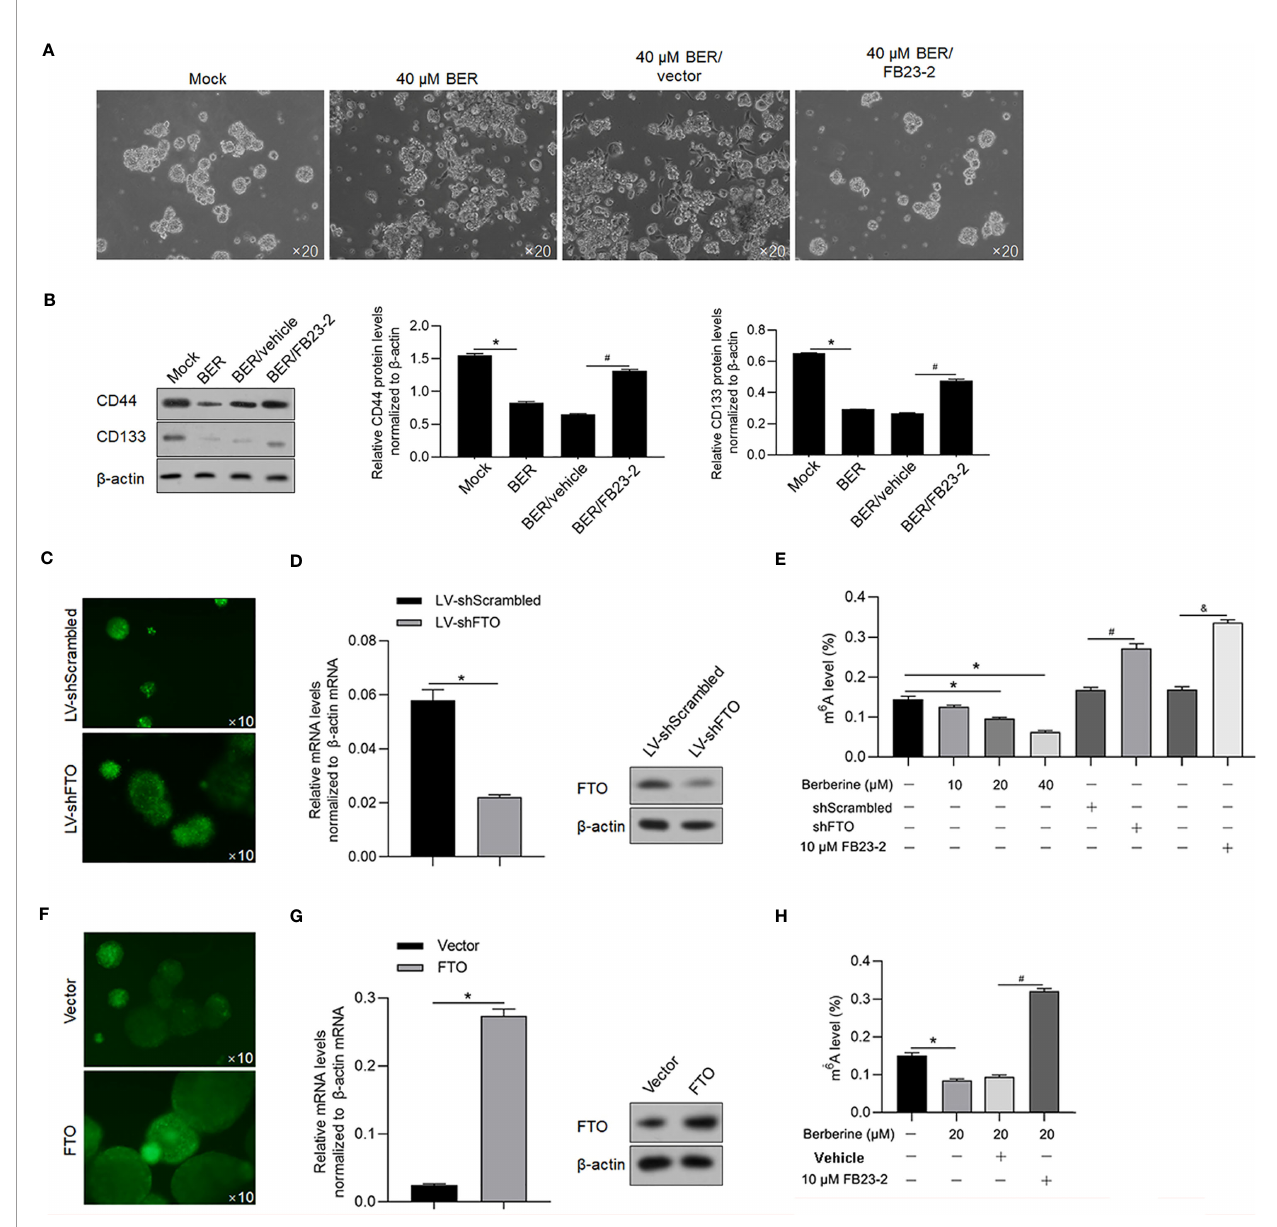
FIGURE 4 | Berberine regulated m6A methylation and sphere formation via regulating FTO. (A) With the addition of 40 m M of Berberine, sphere formation of HCT116 was observed after a 14-day culture. (B) Western blot was performed to detect CD44 and CD133 protein levels in HCT116 CSCs. *p < 0.05, vs. mock group; # p < 0.05, vs. BER/vehicle group. Lentivirus containing shRNA coding sequence target to FTO mRNA was ef fi ciently transfected into HCT116 CSCs (C) and ef fi ciently knockdown FTO protein (D) . (E) Total m 6 A levels in HCT116 CSCs were measured. *p < 0.05, vs. mock group; # p < 0.05, vs. shScrambled group; & p < 0.05, vs. mock group. FTO was ef fi ciently transfected into HCT116 cells (F, G) . (H) Total m 6 A levels in HCT116 CSCs were measured. *p < 0.05, vs. mock group; # p < 0.05, 20 m M Berberine-treated